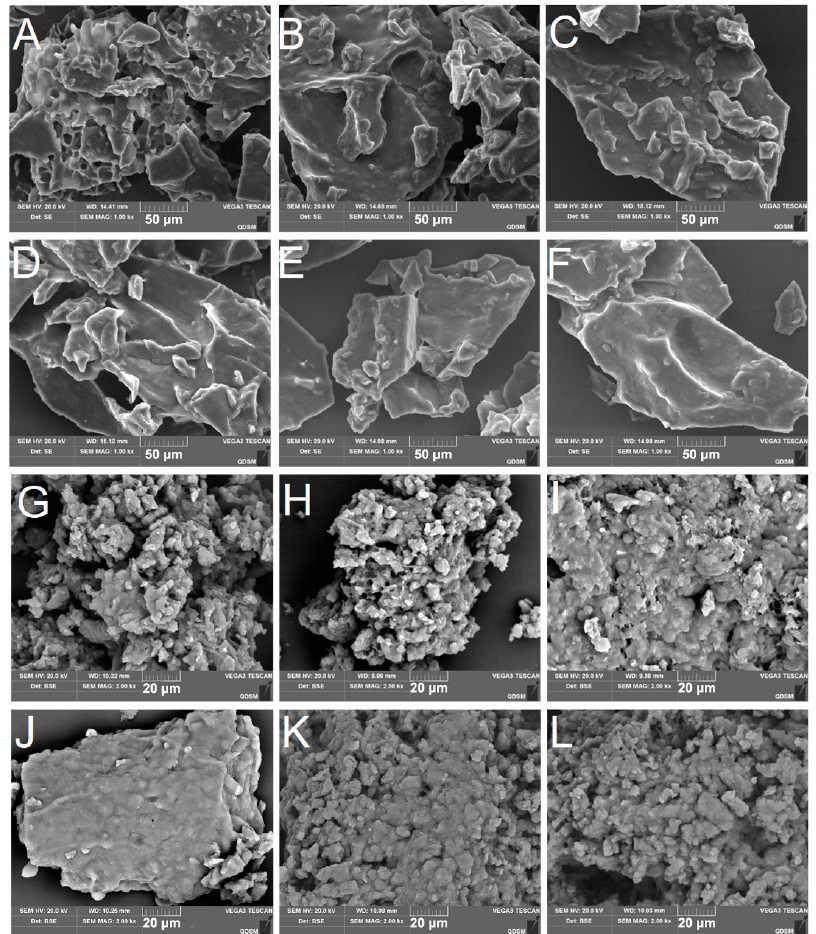
Figure 5. Electron microscope pictures of raw surimi paste and cooked surimi with different polysaccharides. Raw surimi paste: ( A – F ) at magnification 1000×, cooked surimi: ( G – L ) at magnification 2000×. AG: control; BH: κ -carrageenan (KC); CI: konjac gum (KG); DJ: xanthan gum (XG); EK: guar gum (GG); FL: sodium alginate (SA).